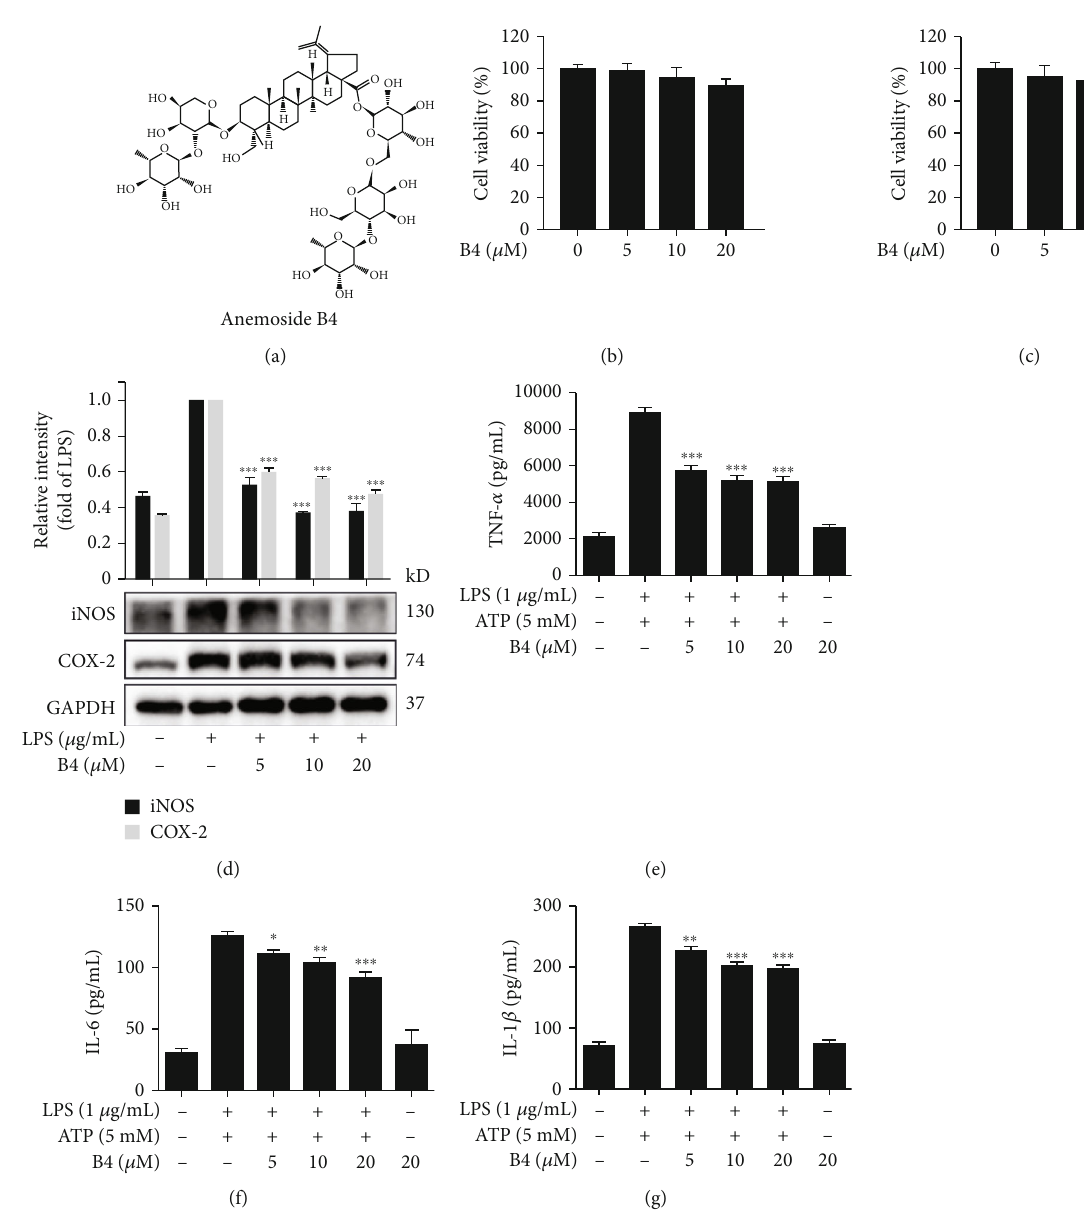
Figure 1: B4 decreased proin fl ammatory response in macrophages. (a) Chemical structure of B4. (b, c) J774A.1 and THP-1 cells were treated with B4 (5, 10, and 20 μ M) for 24h, and the cell viability was detected by MTT assay. (d) THP-1 cells were pretreated with B4 (5, 10, and 20 μ M) for 4h and subsequently cocultured with LPS (1 μ g/mL) for an additional 18 h. Western blotting assay was used to detect the expression of iNOS and COX-2. (e – g) THP-1 cells treated with B4 for 4 h and cocultured with LPS (1 μ g/mL) for 5h, then stimulated with ATP (5 mM) for 30min. The medium was collected, and the levels of TNF- α , IL-6, and IL-1 β were detected by ELISA kit. All the experiments were performed three times independently. ∗ P < 0 : 05 , ∗∗ P < 0 : 01 , and ∗∗∗ P < 0 : 001 compared with the model